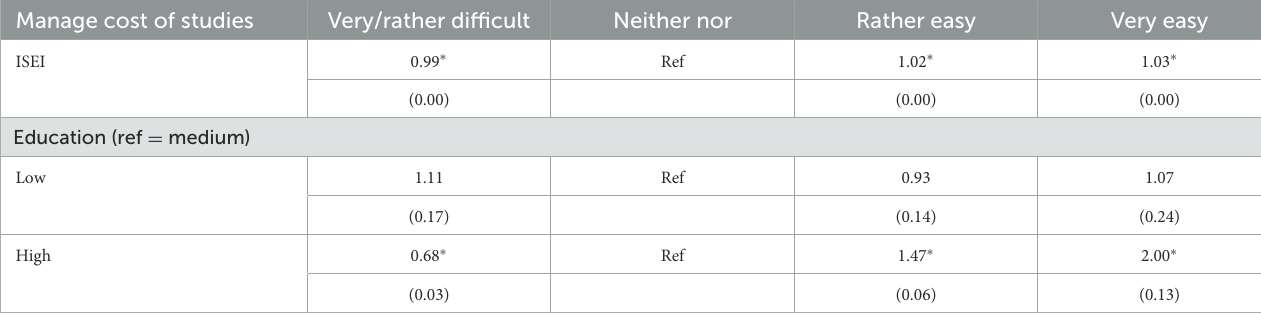
TABLE 6 Logistic regression analyses between material resources and socio-economic background of parents. Manage cost of